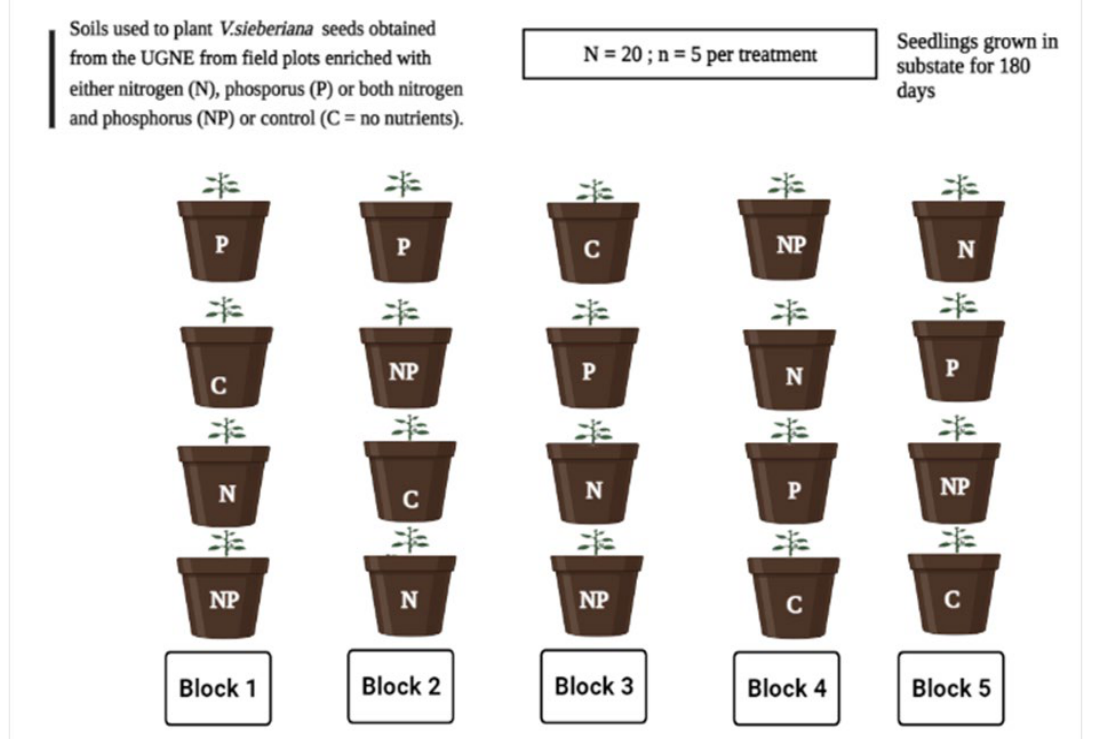
Figure 6. A simple diagram of the layout of treatments in a randomized complete block design in the greenhouse. Key: N = nitrogen, P = phosphorus, NP = nitrogen and phosphorus, and C = control. Sample size n = 5.